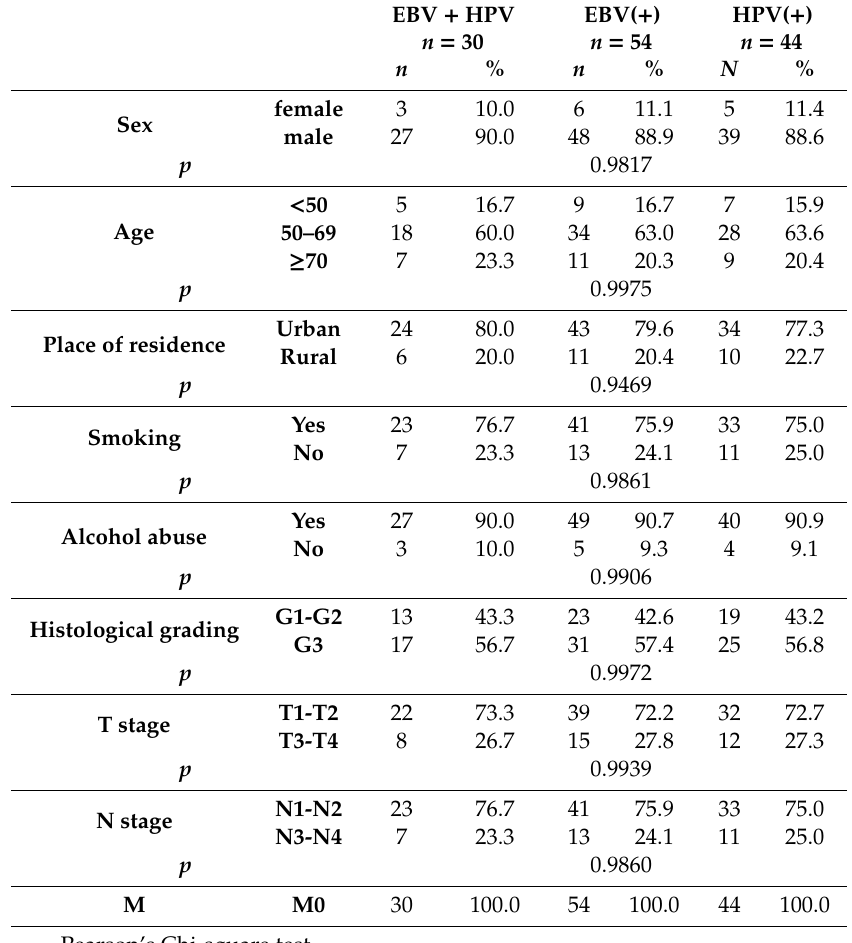
Table 1. Epidemiological and clinical characteristics of oropharyngeal cancer patients with human papilloma virus / Epstein–Barr virus (HPV / EBV) coinfection or with EBV( + ) or HPV( + ) single